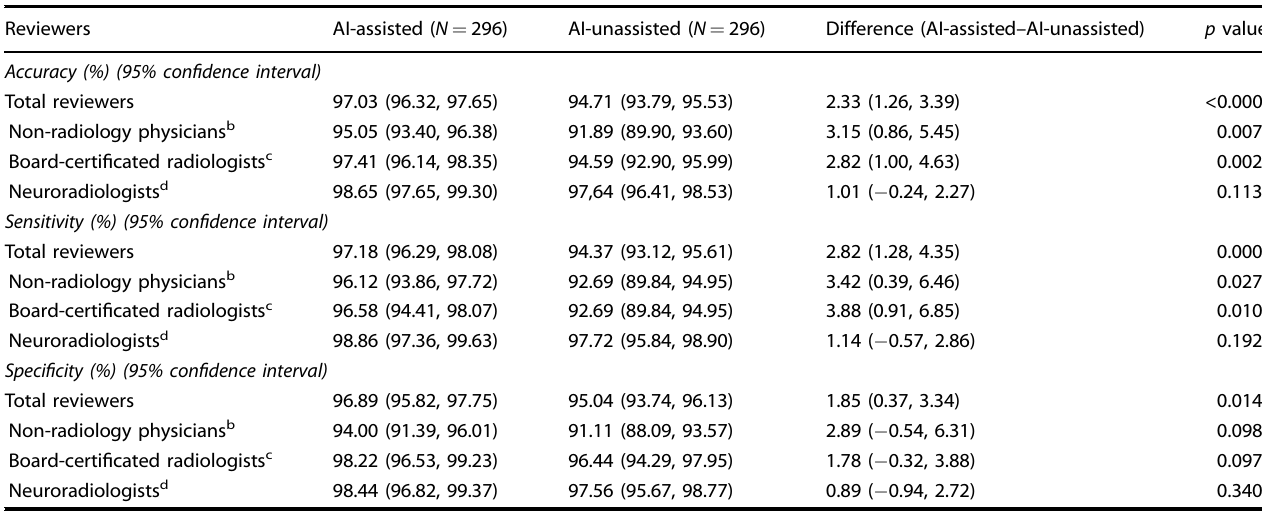
Table 2. Accuracy, sensitivity, and speci fi city of each subgroup after conducting AI-assisted or AI-unassisted evaluation in patient-wise